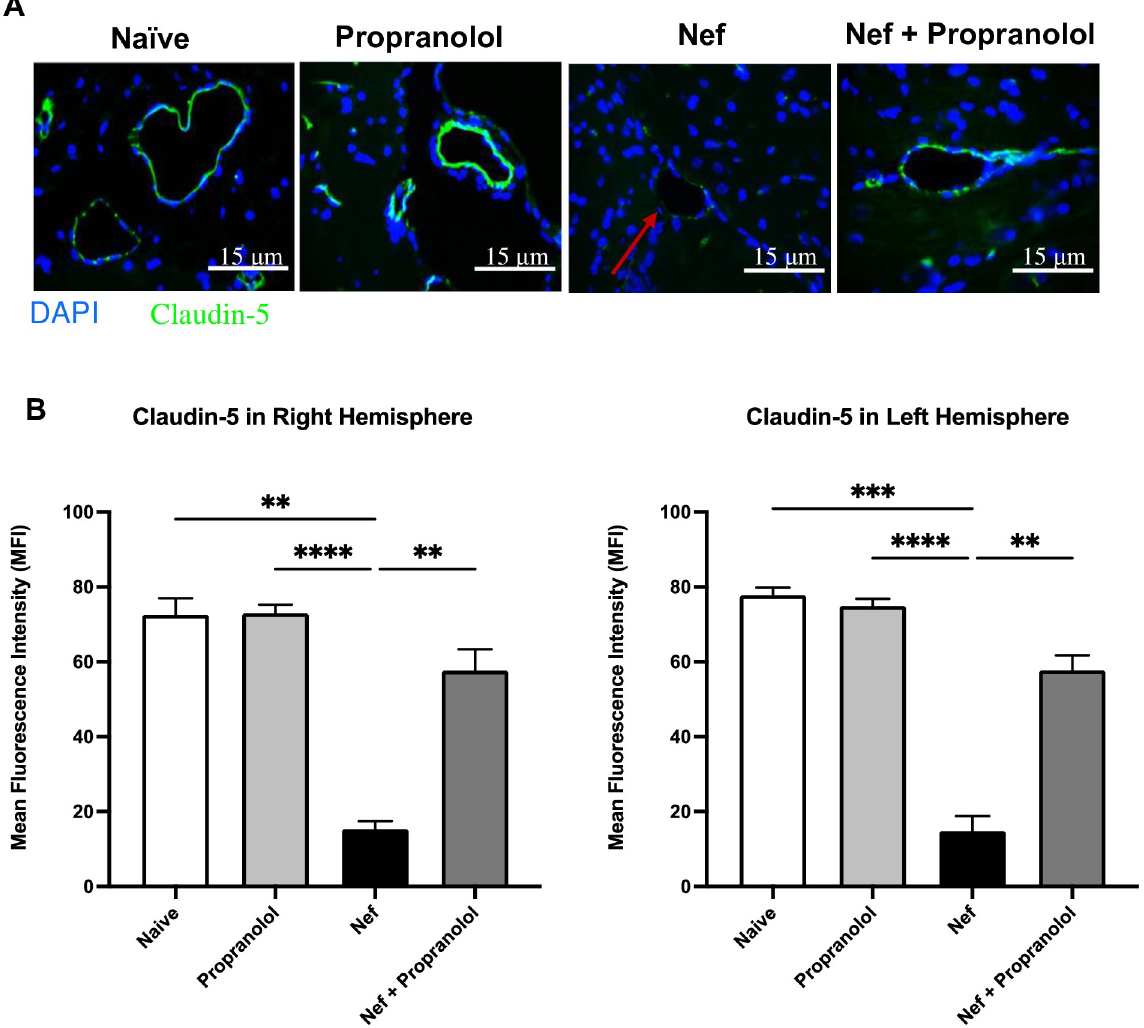
Fig 3. Propranolol attenuates Nef-induced reduction of claudin-5. (A) Representative immunofluorescence images of tight junction protein claudin-5 (shown in green). Absence of strong claudin-5 immunostaining of brain microvessels (red arrow) is predominant in the Nef